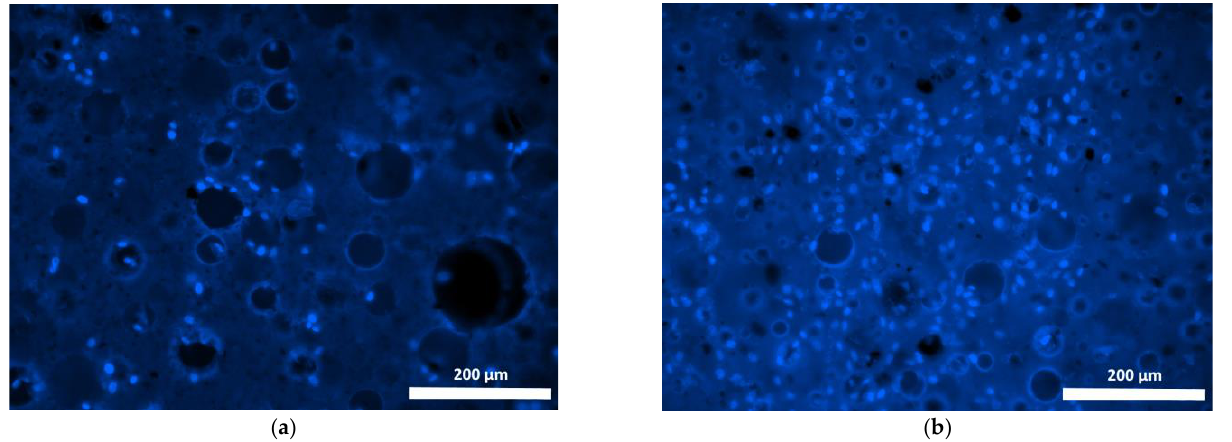
Figure 9. Fibroblast nuclei on the surface of Composition 3 specimen (fluorescence microscopy, fluorochrome—Hoechst 3334, BD Pharmingen™): ( a ) 24 h cultivation; ( b ) 72 h cultivation. mag. 100 × .